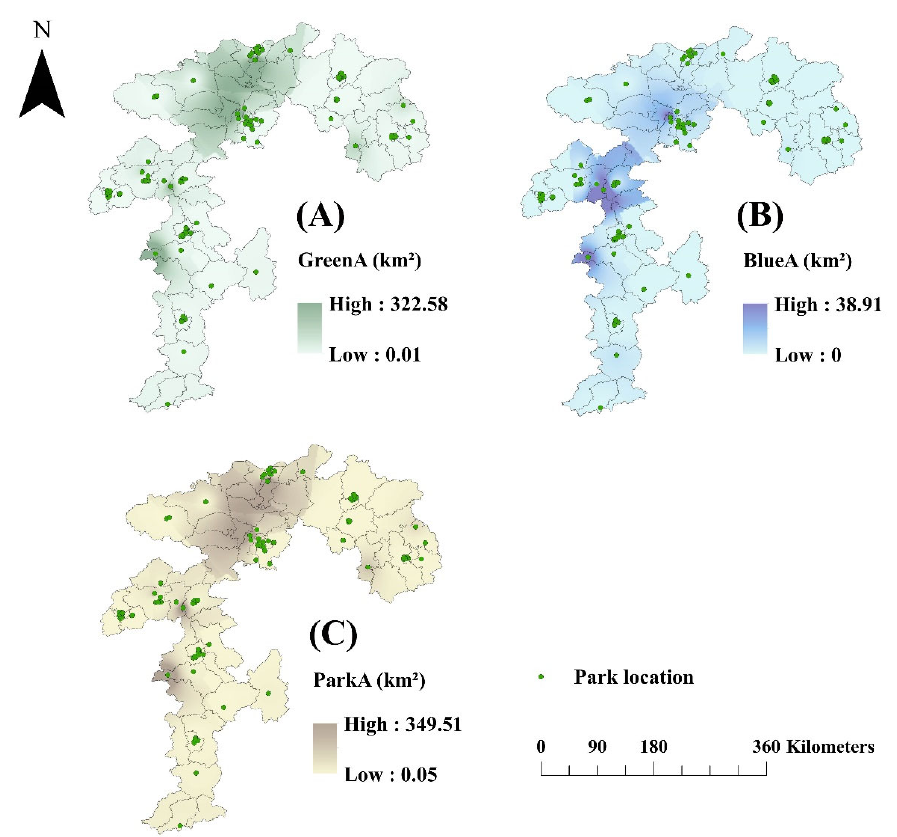
Figure 2. Spatial distributions of areas for urban green spaces (GreenA) ( A ), urban blue spaces (BlueA) ( B ), and UWPs (ParkA) ( C ) in Jiangxi.